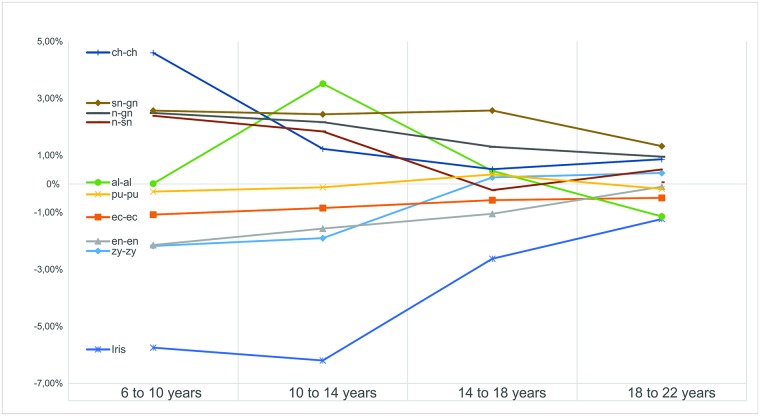
Average Relative Growth of the 10 measurements studied according to an age-segmental analysis.